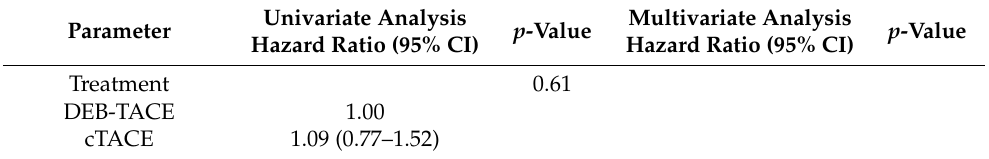
Table 3. Cox proportional hazard regression analysis for overall survival after propensity score